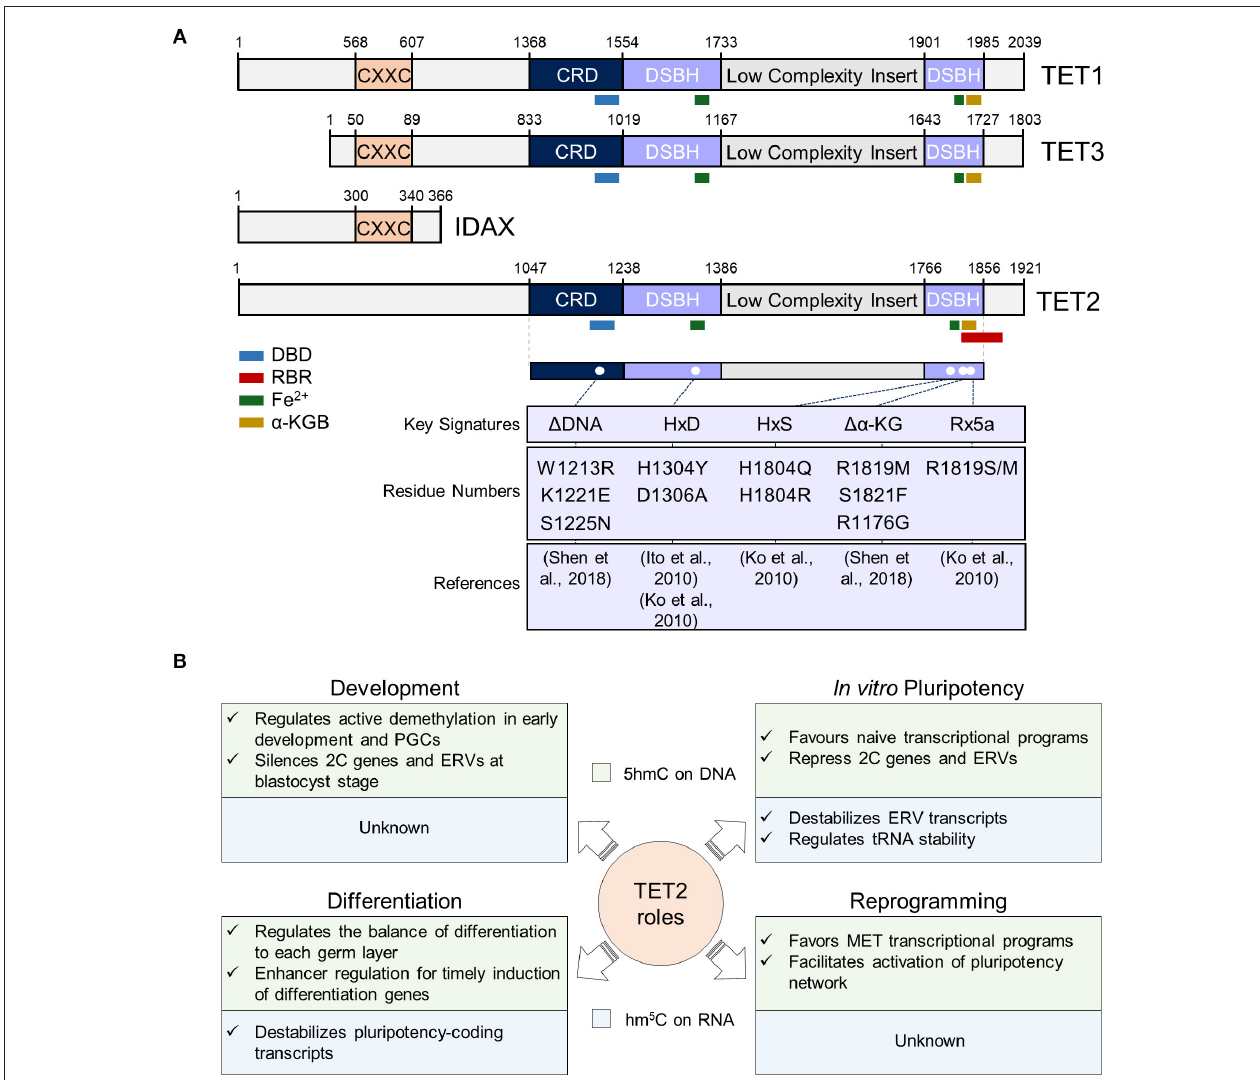
FIGURE 1 | Overview of TET2 structure and functions in different cellular contexts. (A) TET2 structure in the context of TET proteins. In the top panel, sequences of mouse TET1 (NP_001240786.1), TET2 (ACY38292.1), TET3 (NP_001334242.1), and IDAX (NP_001004367.2) proteins are represented. The numbers represent the amino acid numbers. The two conserved domains cysteine-rich (CRD) and double-stranded beta-helix (DSBH) domains are indicated [based in Hu et al. (2013) and Iyer et al. (2009) alignments]. The conserved CXXC domain is also represented (coordinates were obtained from NCBI database). The TET2 RNA Binding Region (RBR) sequence described by He et al. (2016), was mapped first in the isoform 1 of TET2 (NP_001035490.2), and then in ACY38292.1 TET2 sequence. The interaction sites with DNA (DBD), RNA, Fe 2 + and α -Ketoglutarate ( α -KG) cofactors are also represented, and their sequences, also shown by Ito et al. (2010) and Hu et al. (2013), were obtained from the NCBI database. In the lower panel, described mouse TET2 mutations are shown. Since the indicated mutations have been mapped in the ACY38292.1 sequence, possible discrepancies may appear in the mutated positions according to the reference article. (B) Summary of TET2 functions in pluripotency and during development, differentiation, and somatic cell reprogramming. TET2 functions in these processes at the DNA and RNA level is indicated in the light green and blue squares, respectively. PGCs, primordial germ cells; 2C, 2-cell embryo; ERVs, endogenous retroviruses; MET, mesenchymal-to-epithelial